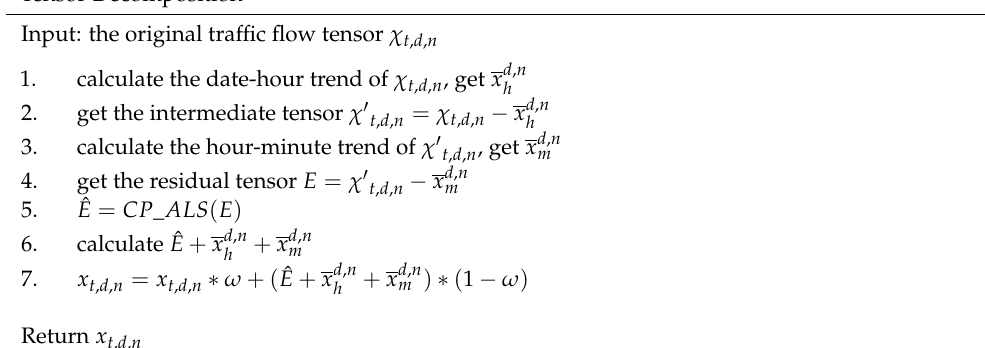
Algorithm 1 The Missing Data Completion Algorithm Based on Residual Value Tensor